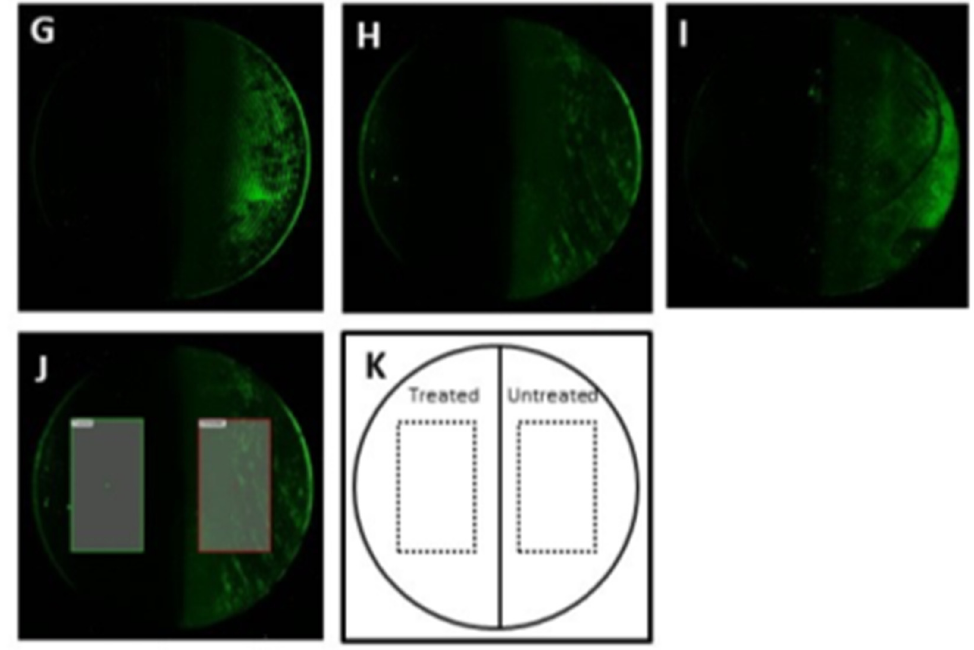
Figure 4. Autofluorescence of bacterial biofilm on M discs before and after treatment with air abrasive unit delivering different powders: ( A ) pristine disc; ( B ) contaminated untreated disc; ( C ) group 7; ( D ) group 1; ( E ) group 2; ( F ) group 6; ( G ) group 3; ( H ) group 4; ( I ) group 5; ( J ) group 4 with boxes for fluorescence measurement; ( K ) diagram showing disc with fluorescence measurement rectangles. Magnification 4× and rectangle area of 11.5 mm 2 .